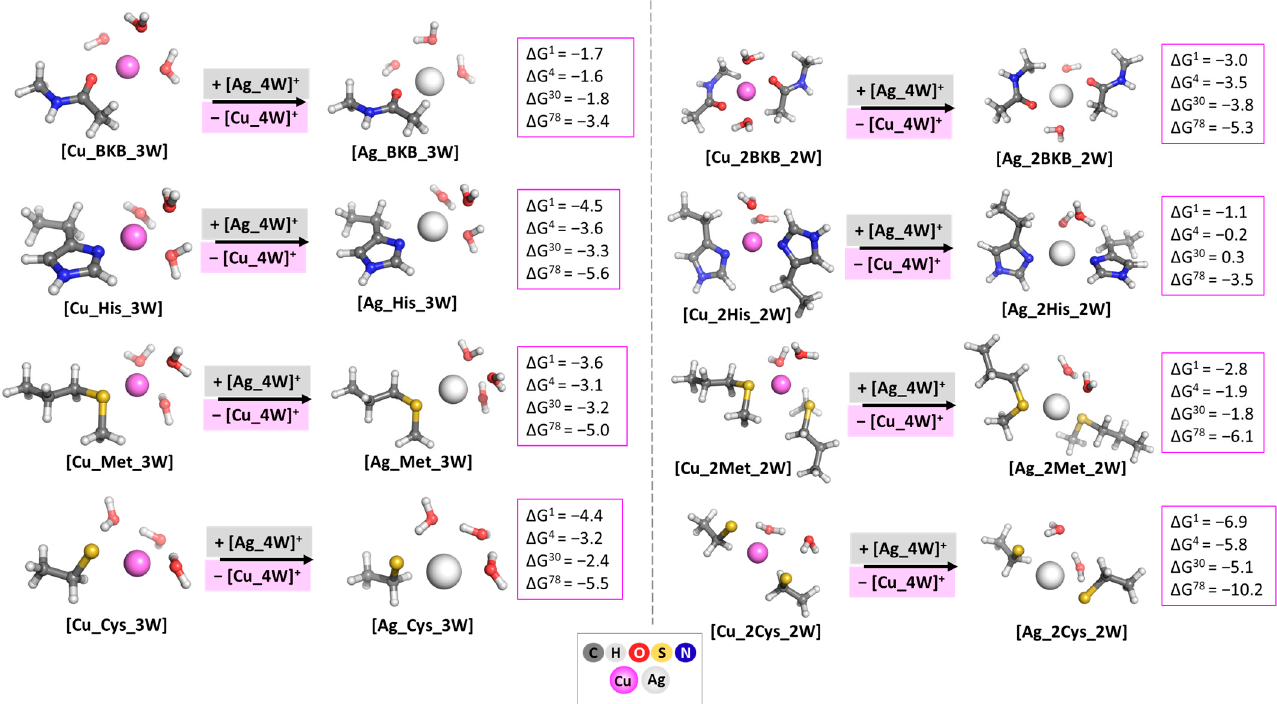
Figure 3. Gibbs energies of Ag + → Cu + substitution given in kcal mol − 1 in four different environments (denoted as ∆ G 1/4/30/78 ) for M062X/6-311++G(d,p)/SDD-optimized [M_1/2AAM_3/2W] structures. The color scheme is further applied in all presented figures.